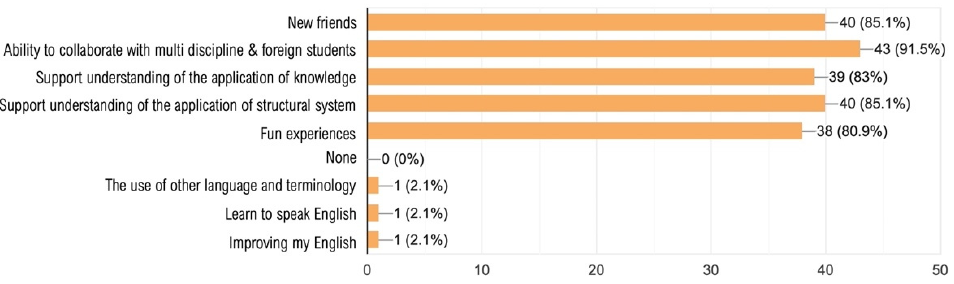
Figure 8. Relevancy and support of the event in enhancing the knowledge of students.